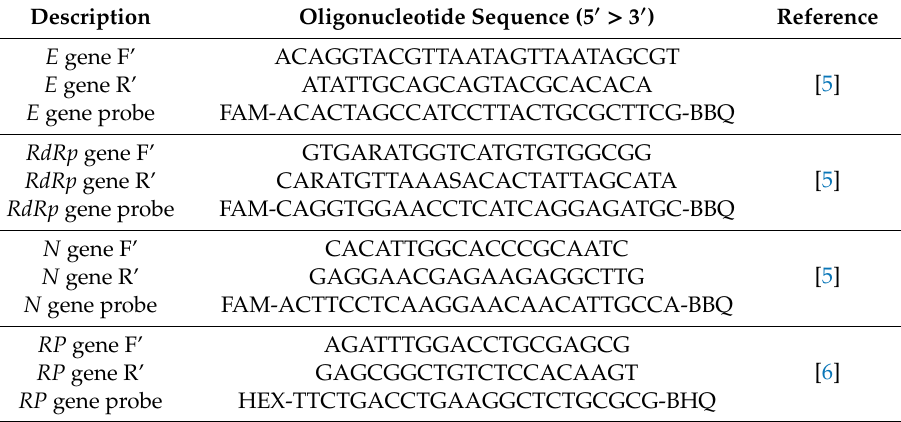
Table 1. 2019-Novel Coronavirus (SARS-CoV-2) Real-Time RT-PCR Panel Primers and Probes. Description Oligonucleotide Sequence (5 (cid:48) > 3 (cid:48)